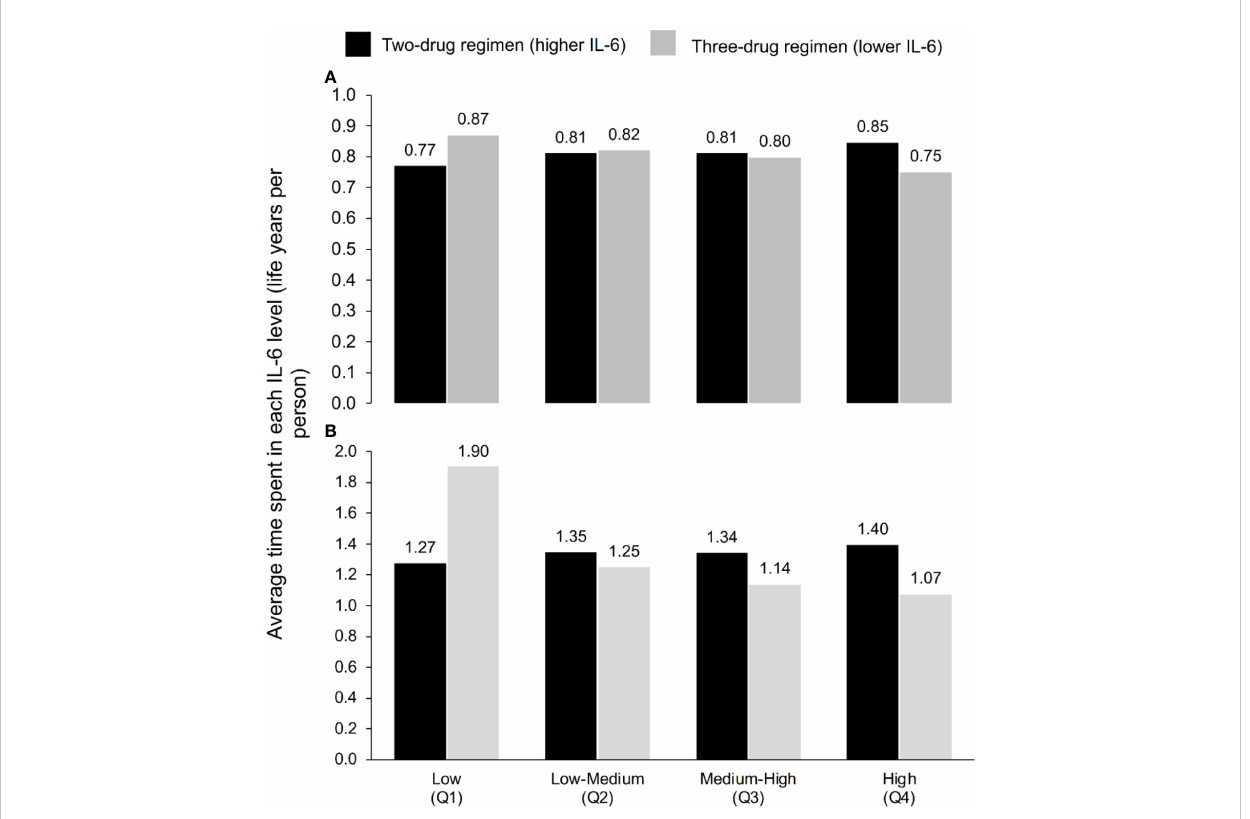
FIGURE 1 Average time spent in each IL-6 quartile according to ART regimen at (A) 3 years and (B) 5 years, according to the model, which used the IL-6 trajectories seen in TANGO (n=741, up to Week 144) and AIR (n=148, Weeks 144 –